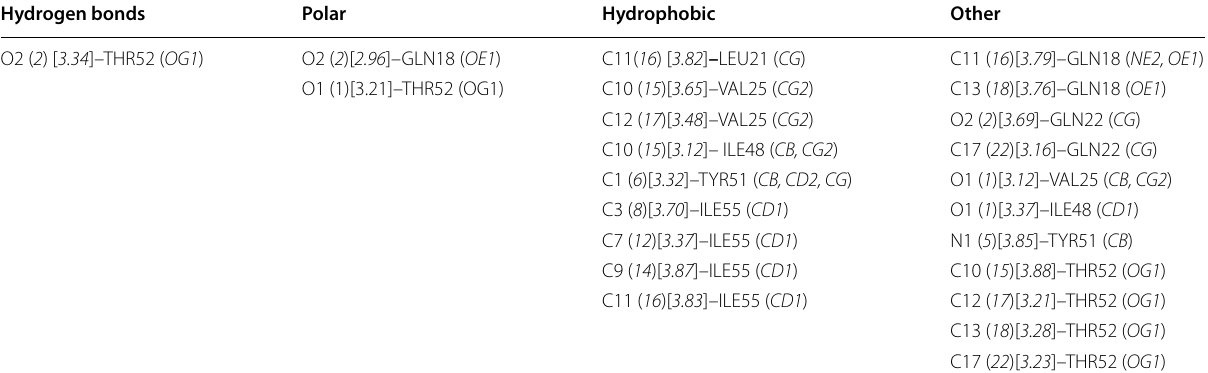
Table 1 Interaction table Hydrogen bonds